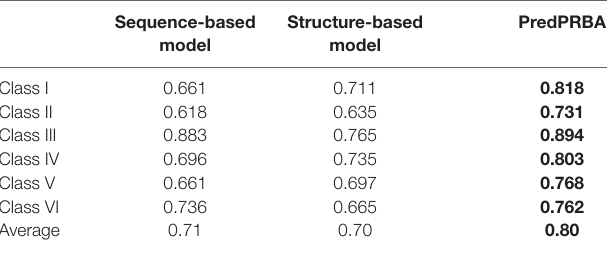
TABLE 5 | Performance comparison of PredPRBA to sequence feature-based and structur efeature-based